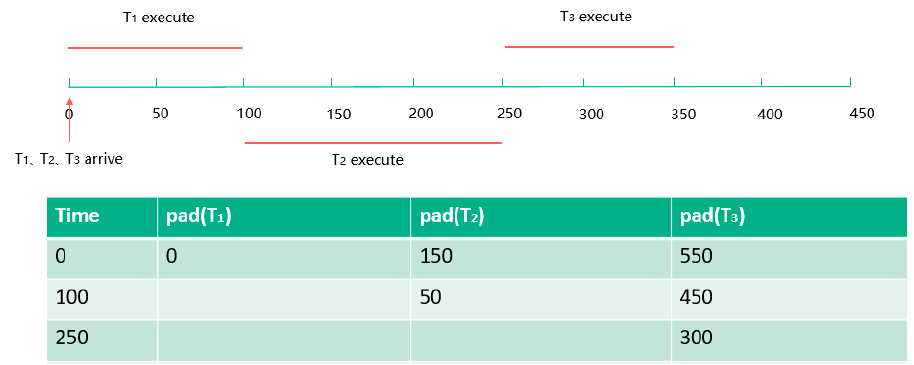
Figure 2. Task execution sequence diagram.